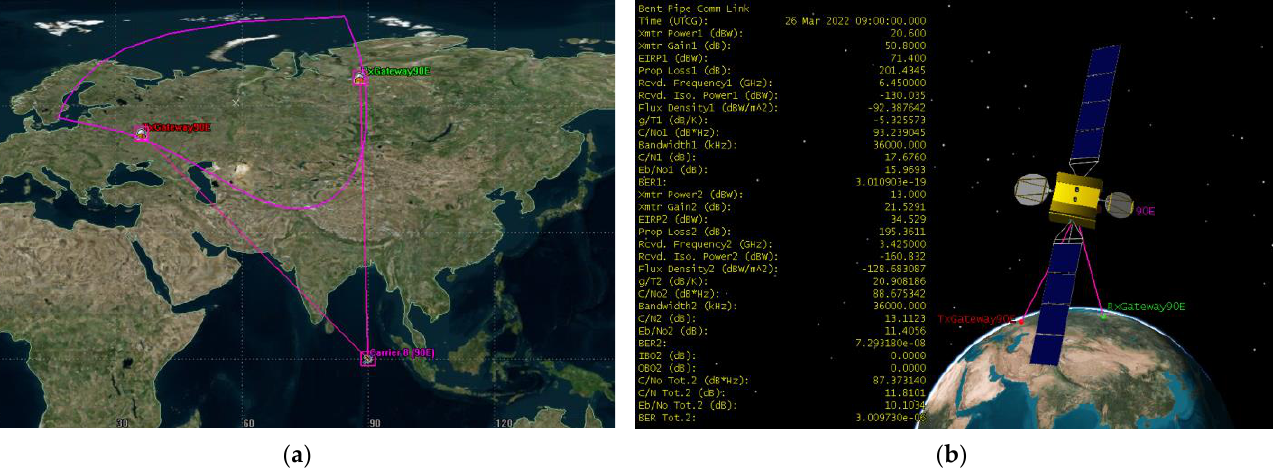
Figure 9. Scenario 1 operation ( a ) 90° E bent pipe transponder operation ( b ) Bent piper of Yamal 90E transponder composite link calculation. Table 4. Parameters of each Monte Carlo simulation step (urban/suburban (rural) macro).